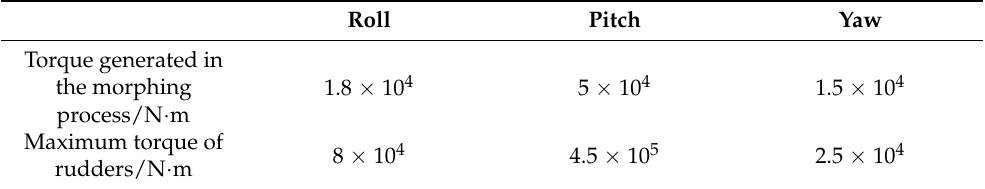
Table 4. Comparison between the torque generated in the morphing process and the control torque of